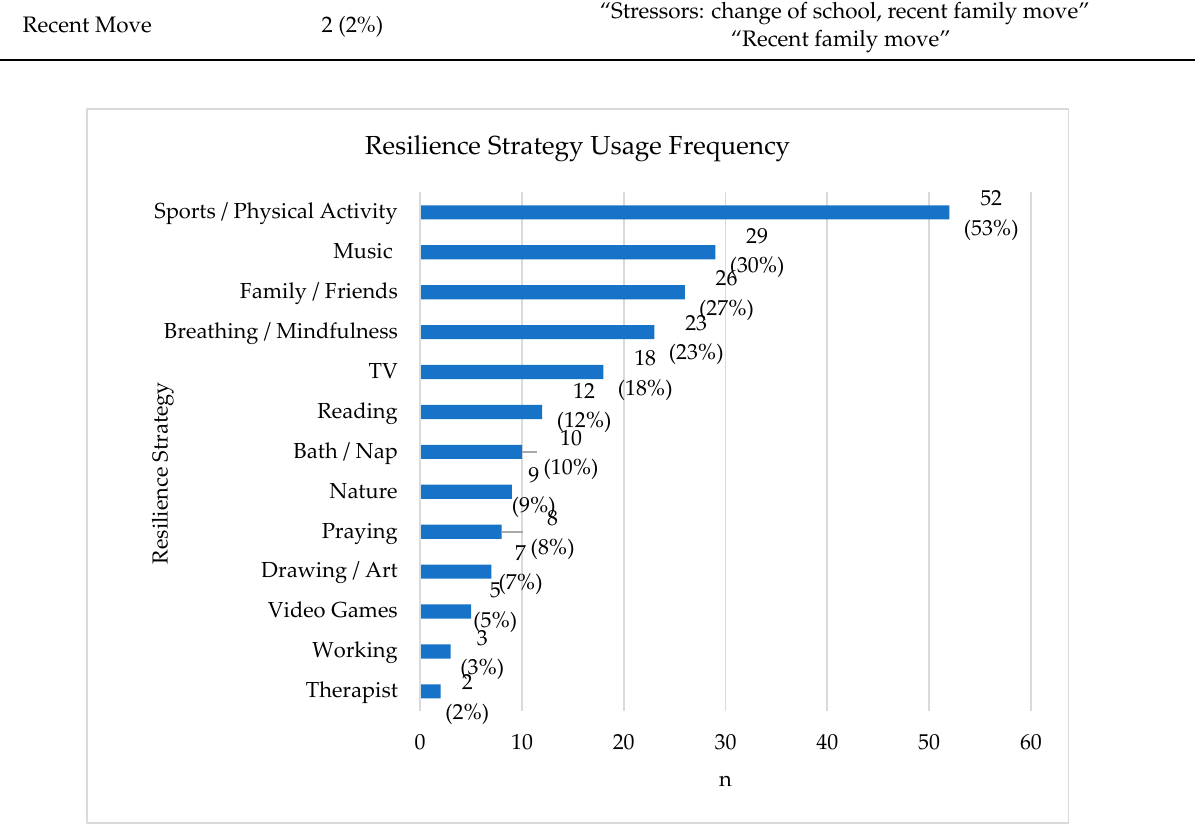
Figure 2. Resilience Strategies .